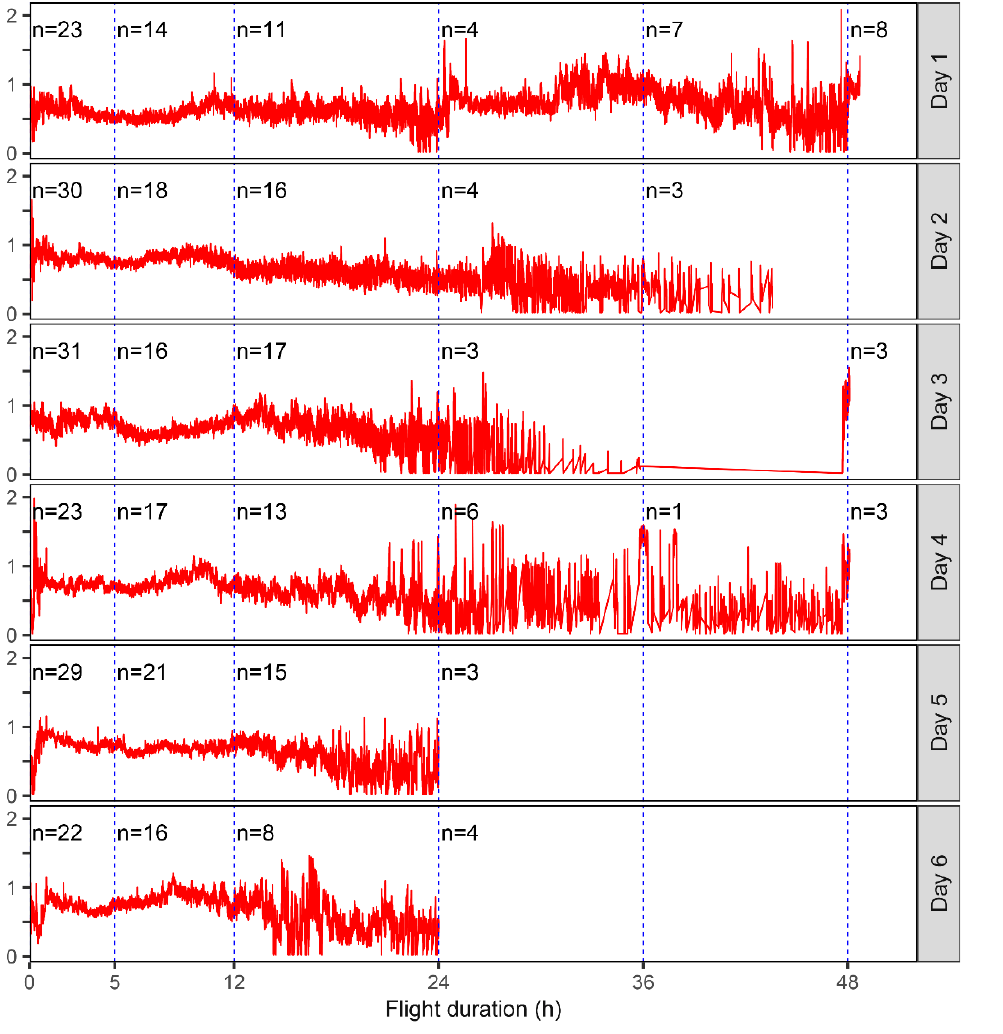
Figure 1. Flight speed and flight duration of S. frugiperda of different ages.